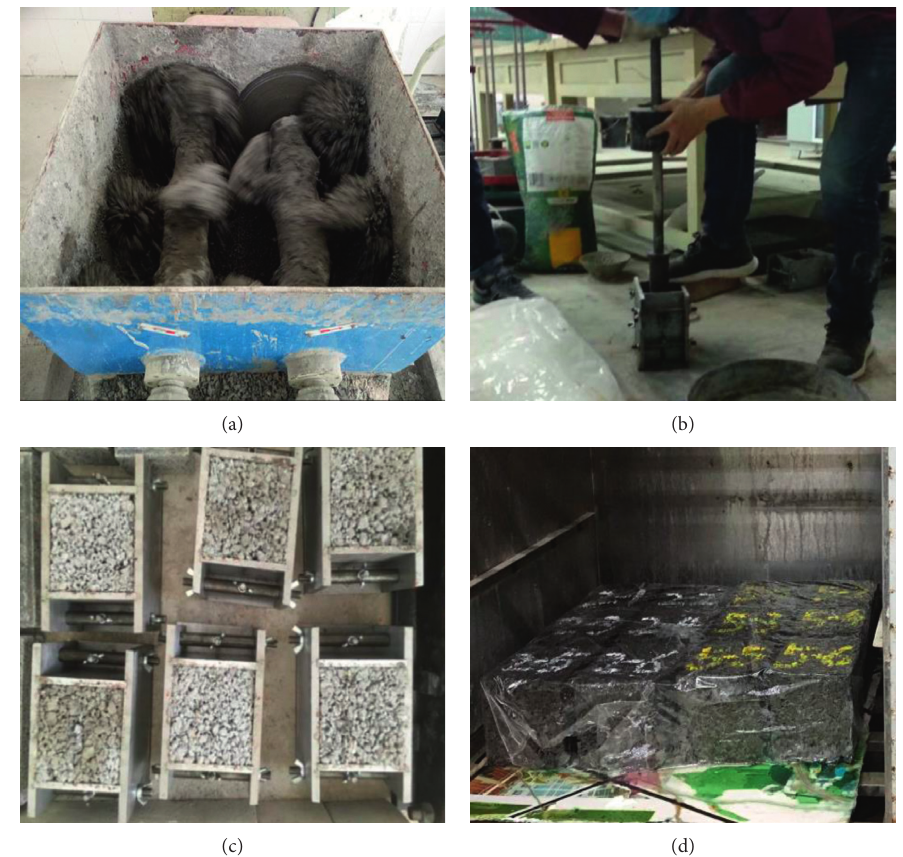
Figure 2: Pervious concrete specimen preparation: (a) mixing; (b) compact; (c) molded specimens; (d)